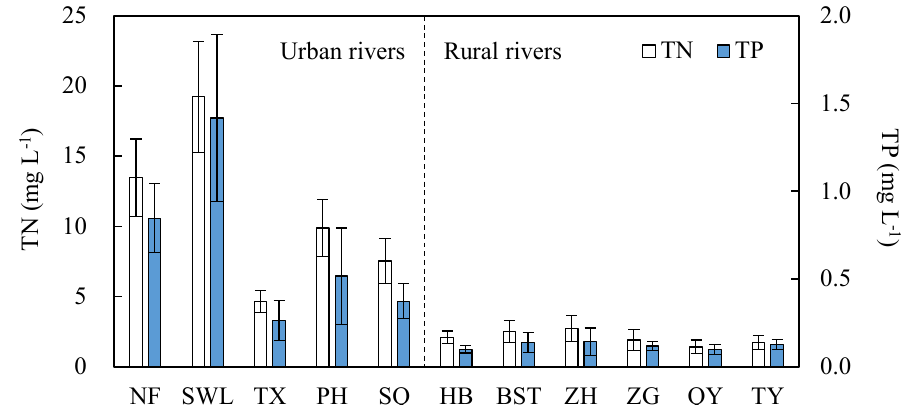
Figure 2. Total phosphorus (TP) and total nitrogen (TN) in 11 rivers flowing into Lake Chaohu. NF = Nanfei River; SWL = Shiwuli River; TX = Tangxi River; PH = Paihe River; HB = Hangbu River; BST = Baishitian River; ZH = Zhaohe River; SQ = Shuangqiao